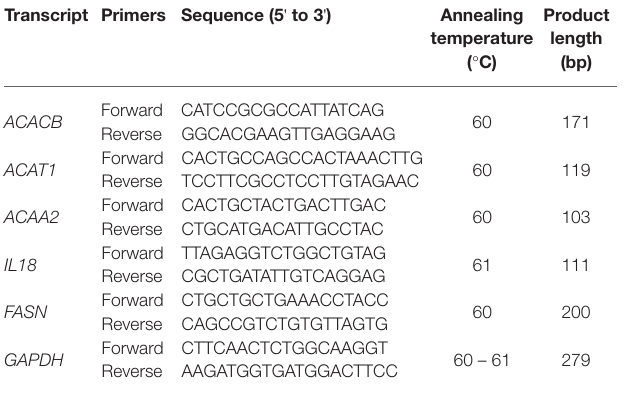
TABLE 1 | Reverse transcription quantitative PCR (RT-qPCR) primer sequences and amplification